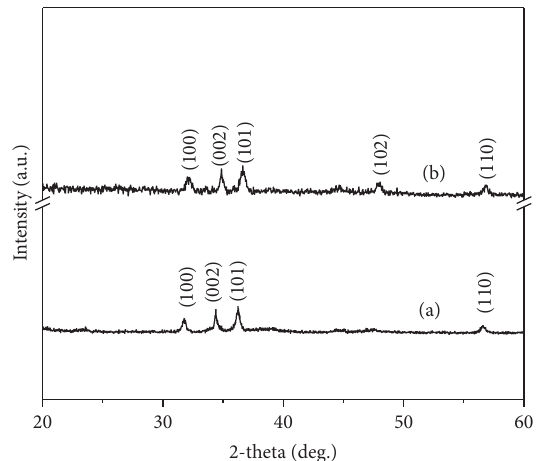
Figure 4: Reversible wettability switching by alternating UV irradi- ation and dark storage.